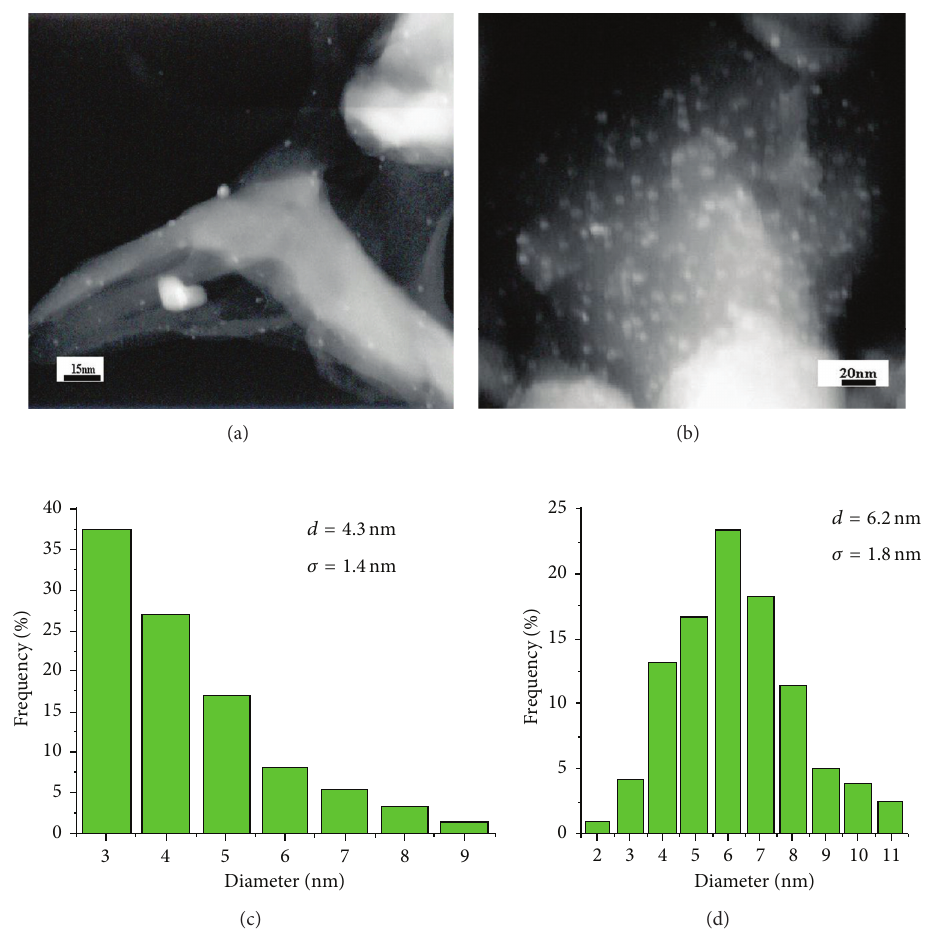
Figure 7: HAADF images and size distribution of Ag nanoparticles obtained from (a), (c) AgNO 3 1.0mM; (b), (d) AgNO 3